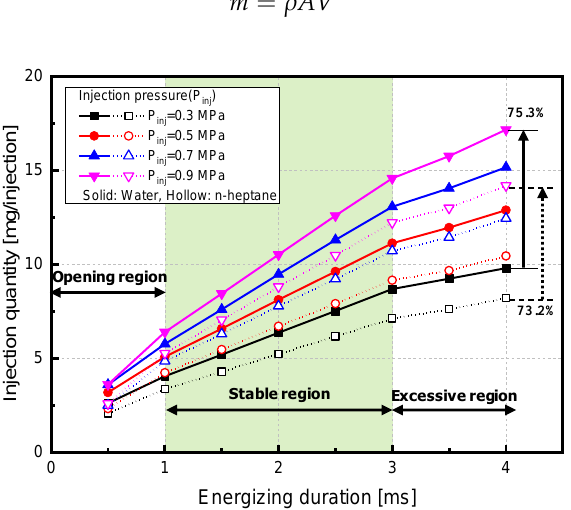
Figure 4. Comparison of the injection quantity between water and n-heptane for the injection pressure and energizing duration.